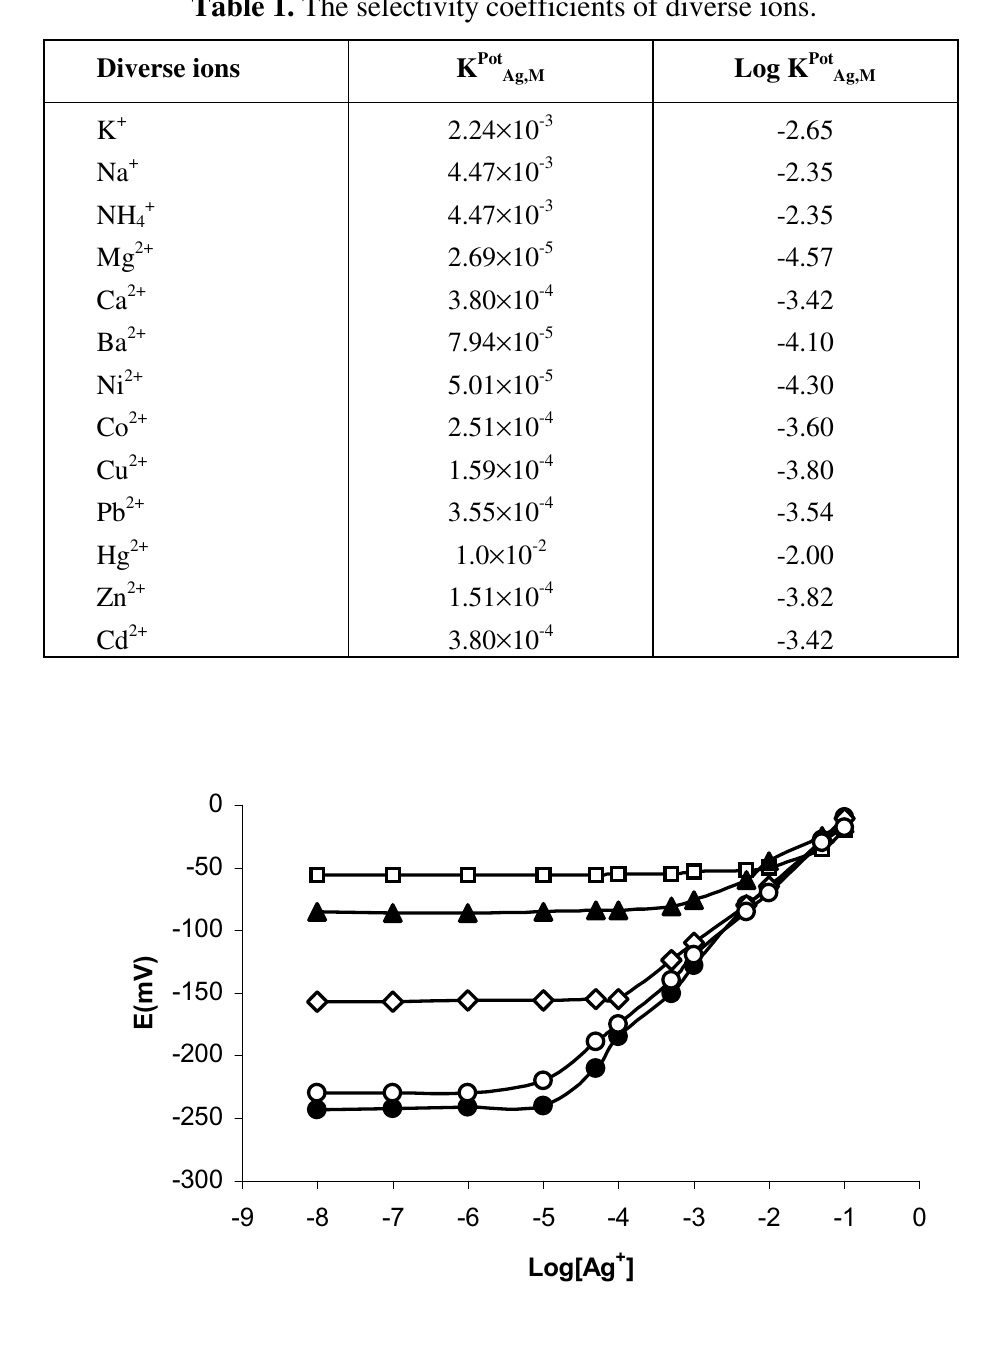
Figure 3. Plots showing E vs Log [Ag + ] in the presence of Hg 2+ ions at varying level of interference ( )1.0 × 10 -2 , ( ∏ )1.0 × 10 -3 , ( ⊄ ) 1.0 × 10 -4 ( ; )1.0 × 10 -5 and ( • ) 0.0